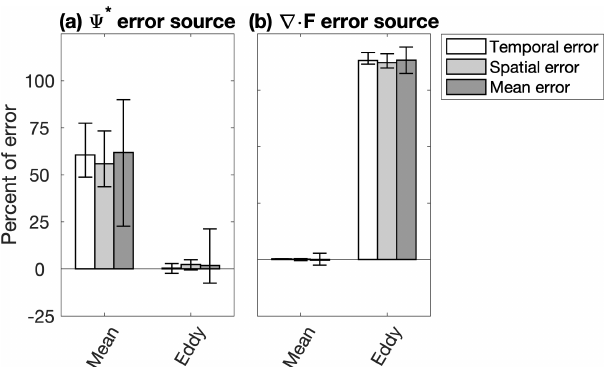
Figure 13. Percent of the temporal, spatial, and mean error in the (a) TEM streamfunction and (b) EP flux divergence attributable to the zonal mean or eddy fields. Whiskers indicate the maximum and minimum across all nudging